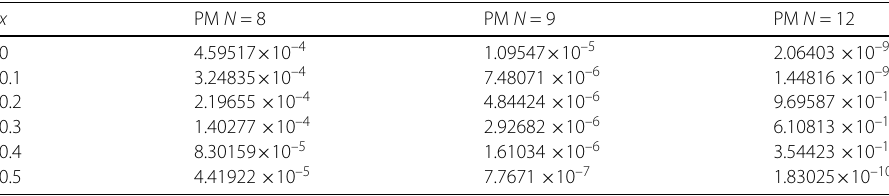
Table 9 Comparison of the absolute errors for Example 5 for different N values at ν 4 = 4 using Chebyshev nodes collocation